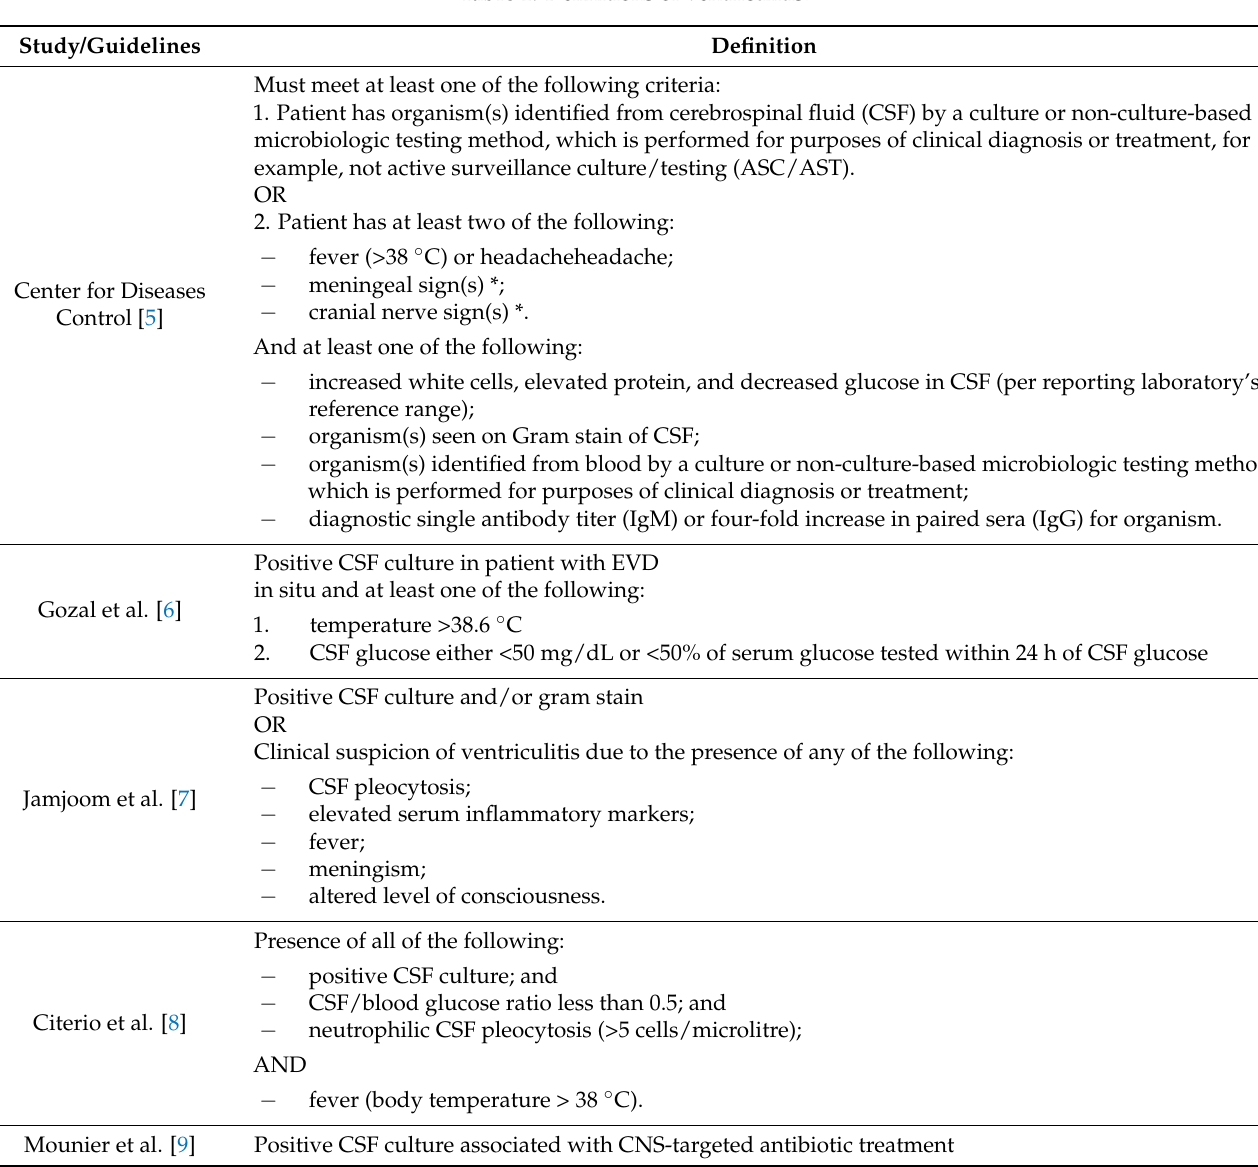
Table 1. Definitions of